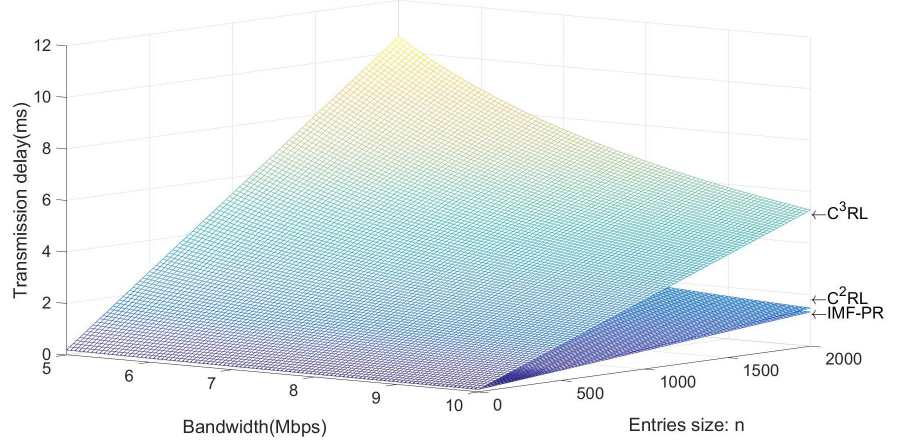
Figure 11. Transmission delay ( α = 0.5, (cid:101) = 0.1%).